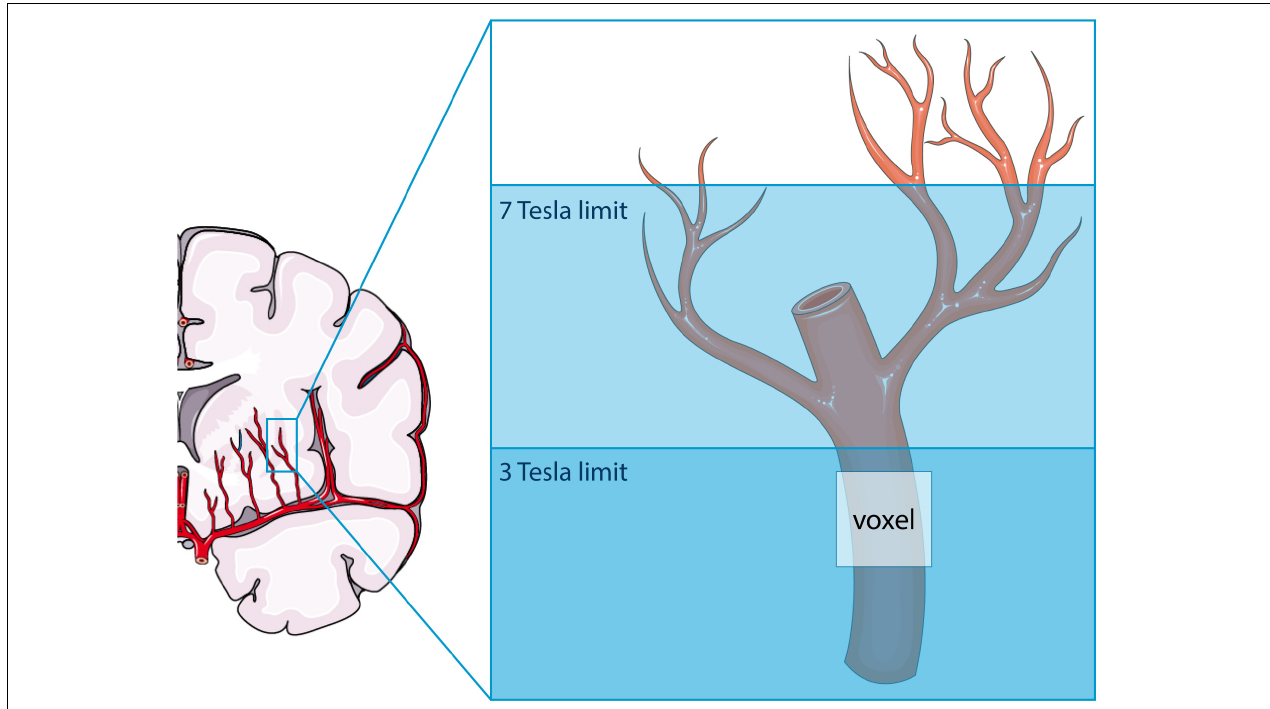
FIGURE 6 | Schematic representation of the difference in sensitivity between 3 tesla (T) and 7T MRI for assessing flow and pulsatility in the perforating arteries in the basal ganglia. Both modalities can only detect the proverbial tip of the iceberg, albeit that this tip is larger at 7T than at 3T MRI. The voxel shown indicates the presence of partial volume effects, which are thus different between 3T and 7T MRI due to the difference in the proverbial tip of the iceberg. This image was created using Servier Medical Art templates, which are licensed under a Creative Commons Attribution 3.0 Unported License;